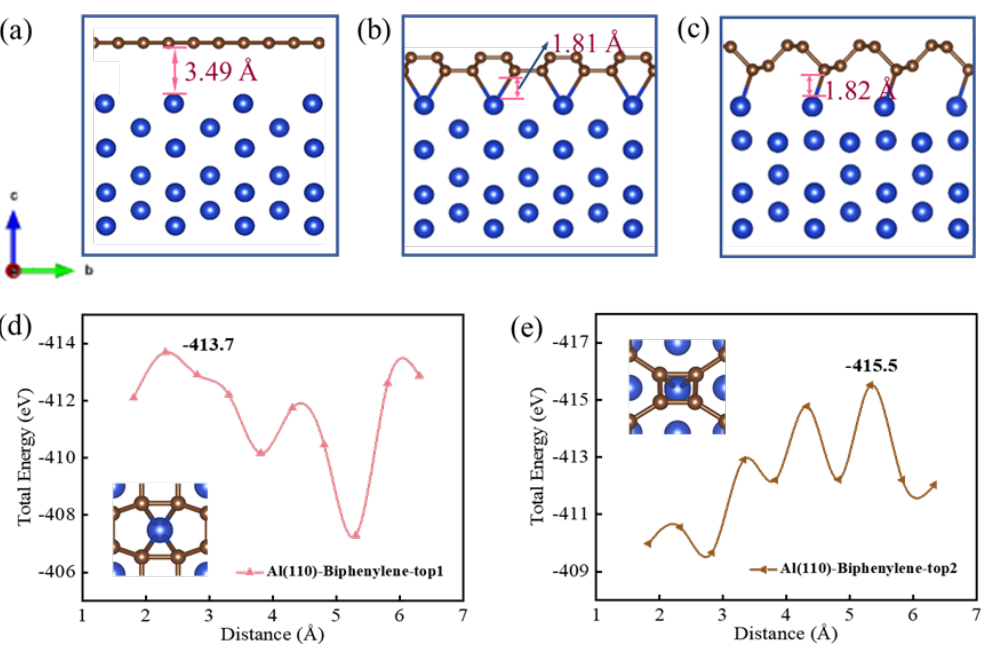
Figure 8. Binding properties of anti-corrosion coatings with aluminum substrate. ( a ) Sectional views of graphene bound with aluminum. ( b , c ) The Bond 1 and Bond 2 of biphenylene. ( d , e ) Energy variation of biphenylene in the coating − stripping process.